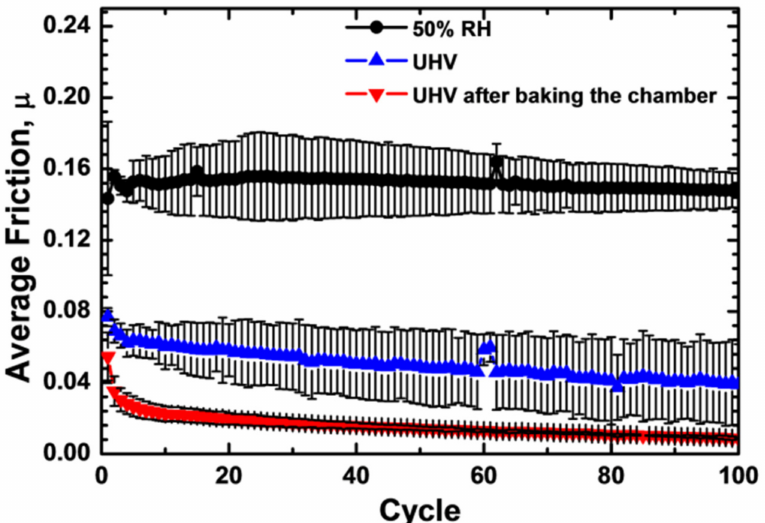
Figure 4. Average friction coefficient vs. cycle for diamond/tungsten sliding tests using a microtri- bometer. The experiments were performed at 50% relative humidity and compared to tests in UHV as well as after baking in the chamber for more than 24